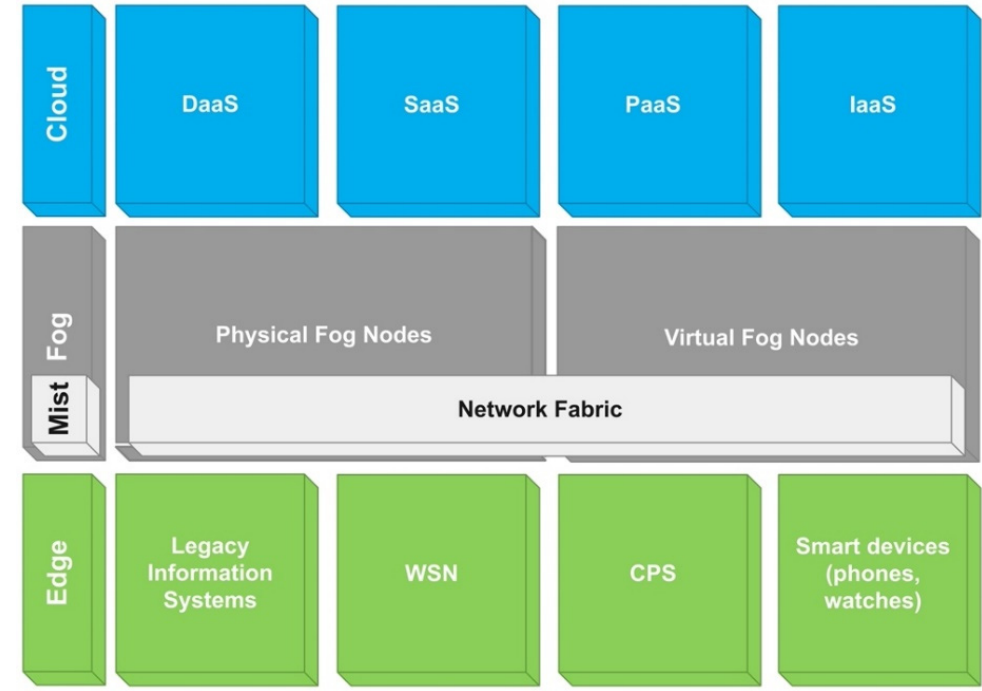
Figure 1. Layered view of the GHPE.